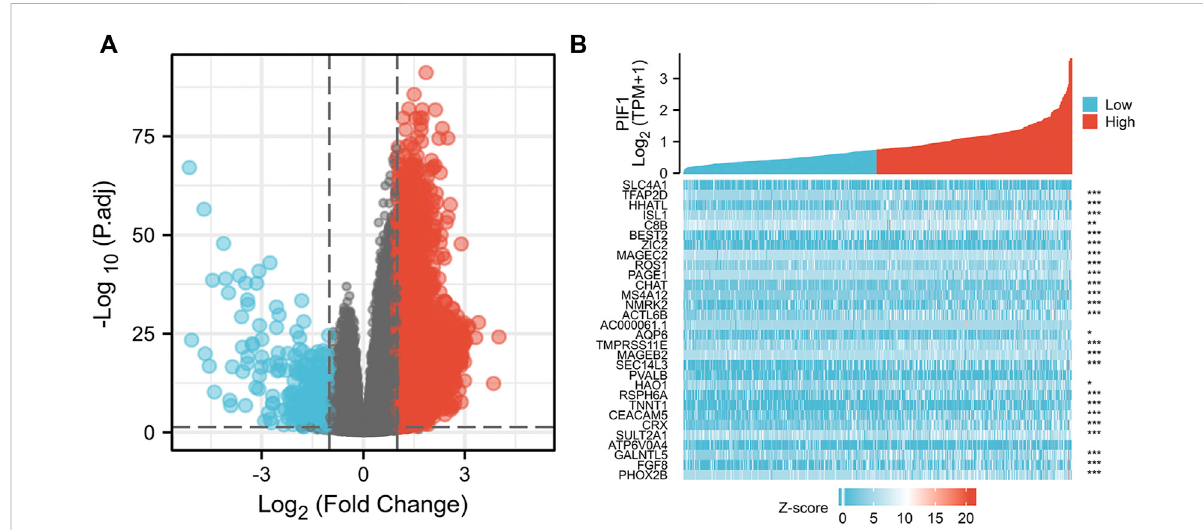
FIGURE 6 Differentially expressed genes between patients with high and low PIF1 expression. (A) Volcano plot of differentially expressed genes between thehighandlow PIF1expressiongroups.Normalizedexpression levelsare shownindescending orderfromgreento red. (B) Heatmapofthetopten signi fi cantly differentially expressed genes between the high and low PIF1 expression groups. Green and red dots represent downregulated and upregulated genes,